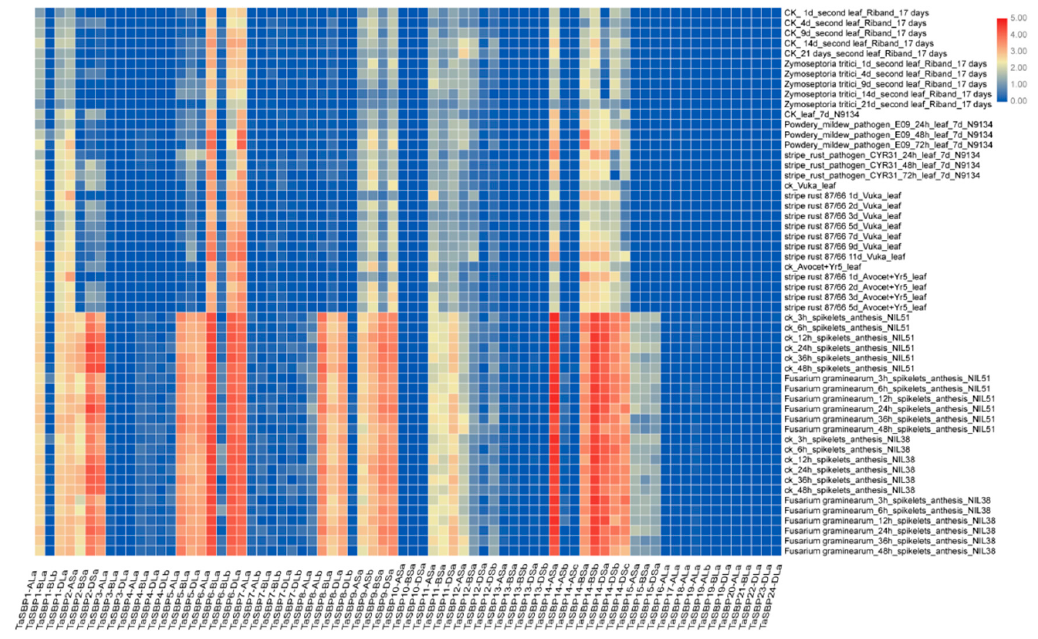
Figure 10. Heat map of expression profiles for TaSBP genes across different stresses under different biotic stress, including Zymoseptoria tritici in leaf (cultivar: Riband), powdery mildew in leaf (cultivar: Riband), stripe rust in leaf (cultivars: Vuka and an Avocet introgression line containing the resistance gene Yr5), and Fusarium graminearum infection in anthesis (cultivar: Remus) (SBA numbers: PRJEB8798, PRJNA243835, PRJNA243835, PRJEB12497 and PRJEB12358). Blocks with colors indicate decreased (blue) or increased (red) expression levels. The gradually change of the color indicates different level of gene log2-transformed expression (fold change > 3 is significantly expressed).